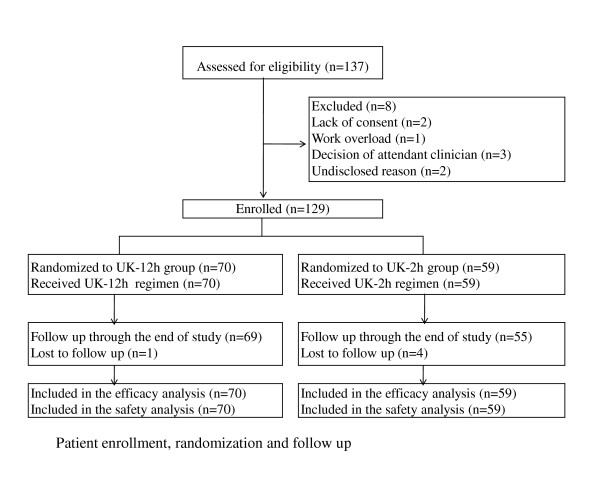
Study flow diagram.